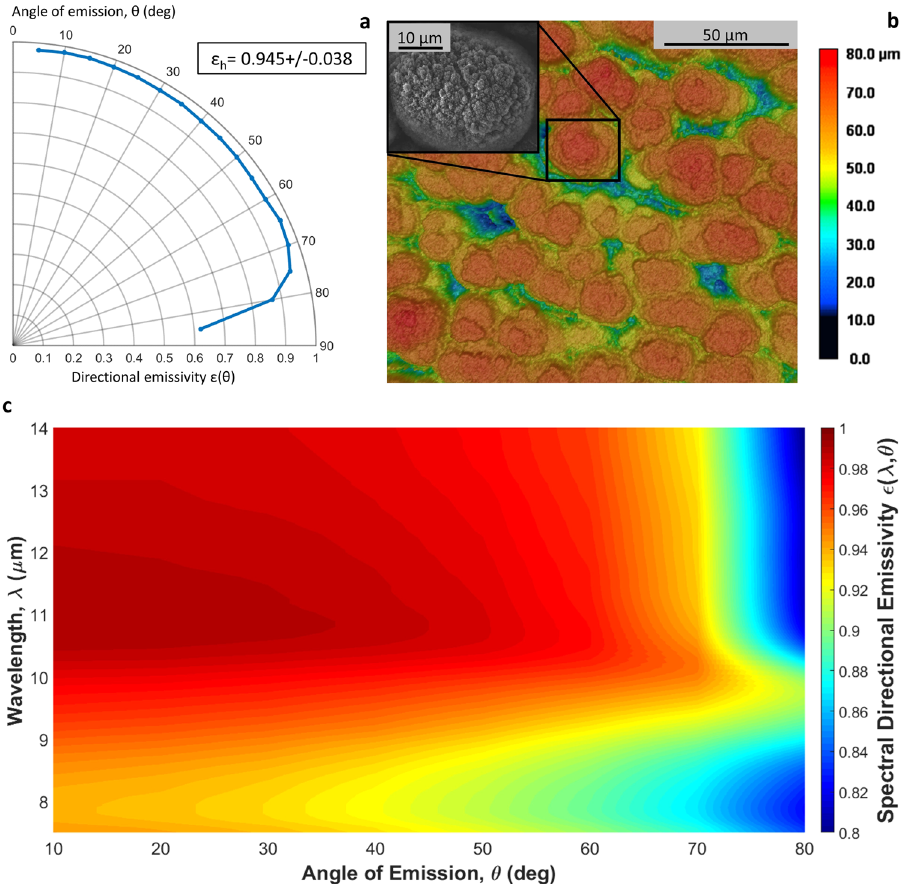
Fig. 1 Near unity broadband omnidirectional emissivity response. a Directional emissivity as a function of emission angle. Zero degrees corresponds with the detector normal to the surface. The average hemispherical emissivity ( ε h ) value is also shown. b 3D LSCM topographic map of the aluminum laser processed surface with an inset SEM image of a single mound. c The spectral directional emissivity of the same surface showing that near perfect broadband omnidirectional emissivity response is obtained. Emissivity values were measured every 10 degrees (from 10 to 80) and approximately every 0.1 µ m and smoothed using